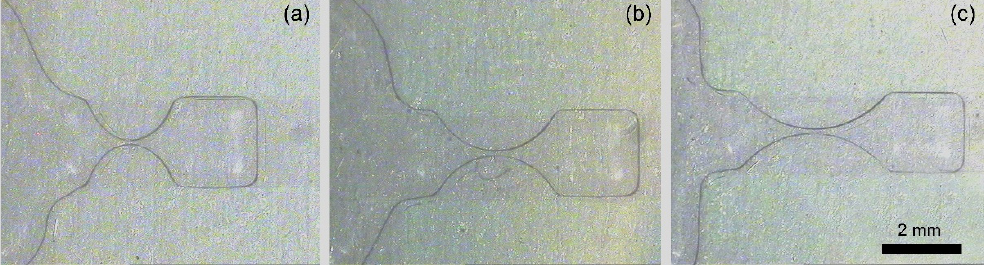
Figure 6. Photos of the liquid neck for the dumbbell-shaped sub-electrode with a length of ( a ) 2 mm, ( b ) 3 mm, and ( c ) 4 mm (the width remains 2 mm). ( b ) 3 mm, and ( c ) 4 mm (the width remains 2